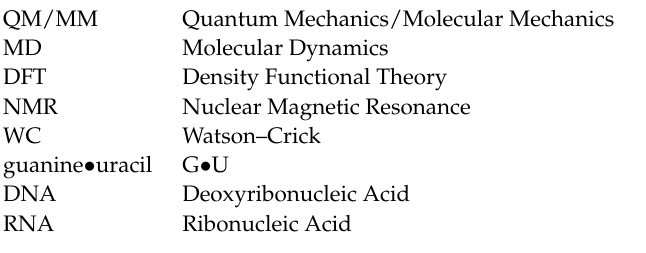
Figure S2: Reaction profile of the constrained TS search for locating TS1 ‡ and TS1 ‡ Geometries of intermediates and transition states computed using QM/MM methods, Table S1: Computation time for optimization of wG • U state in different methods with B3LYP/6-31G* level of theory, Table S2: Imaginary frequencies for transition states obtained using various